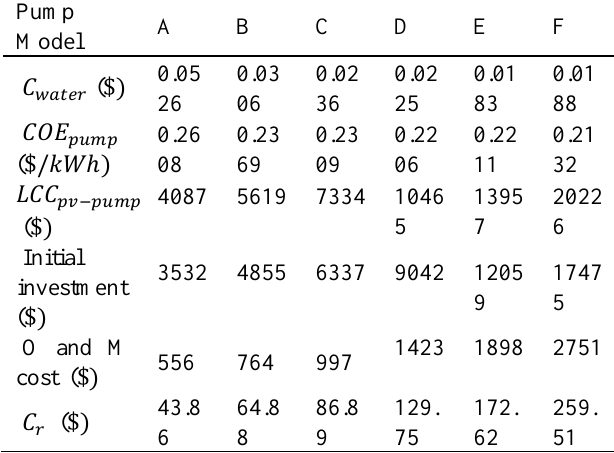
Fig. 4. Cubic meter cost of water for different pumps